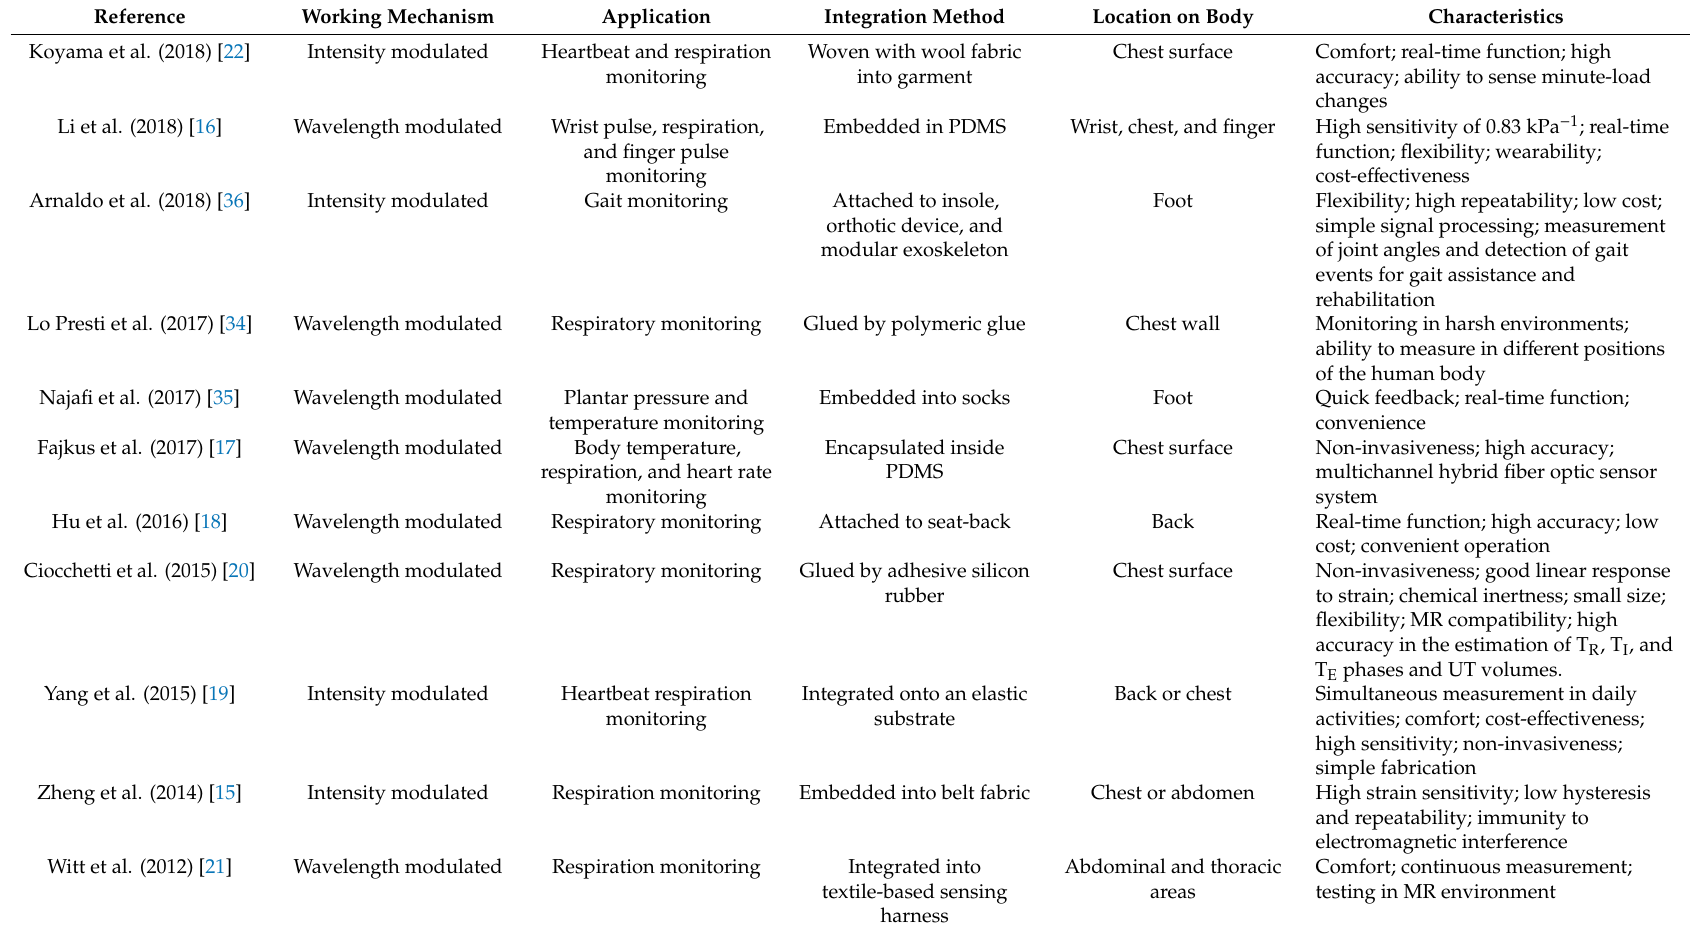
Table 1. Wearable fiber optic technology applications in healthcare